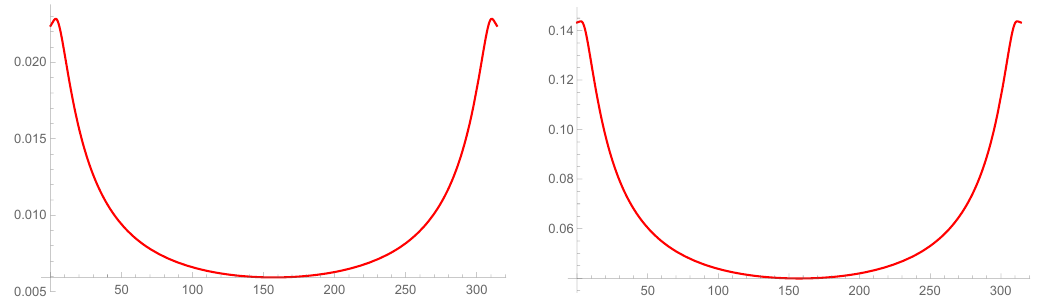
Figure 4. Contribution to the Green’s function from the continuous spectrum. The computation is done at β = 100 π , C = 1 . The left panel is for the even N case; the right panel is for the odd N case. The horizontal axis is the Euclidean time ranging from 0 to 100 π . The vertical axis is the contribution to the Green’s function from the continuous spectrum in percentage. This is the temperature that is relevant to the discussion in [23]